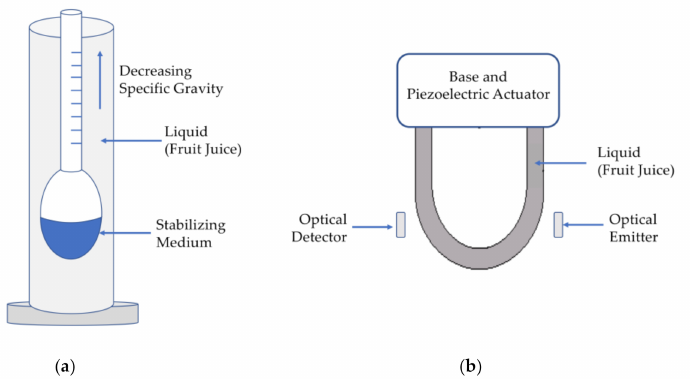
Figure 2. Instruments for Measuring Specific Gravity of Fruit Juice or Fruit Mash. ( a ) Typical hydrometer; and ( b ) oscillating U-shaped tube meter.